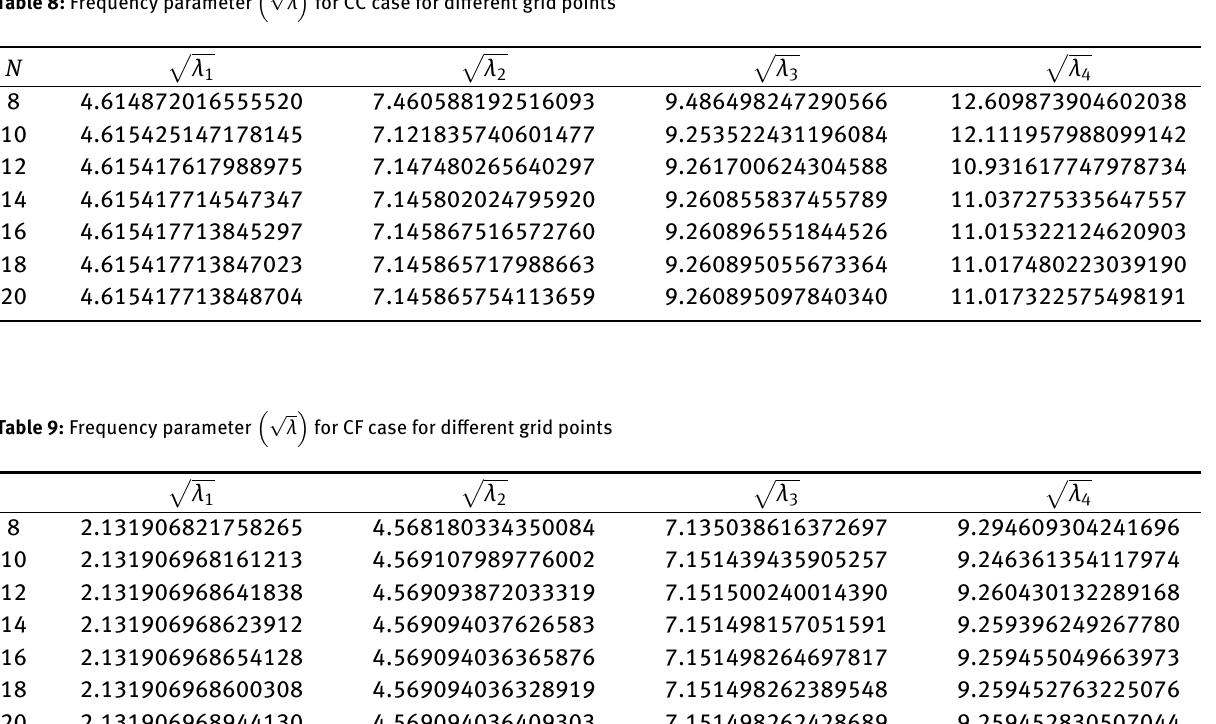
Table 8: Frequency parameter